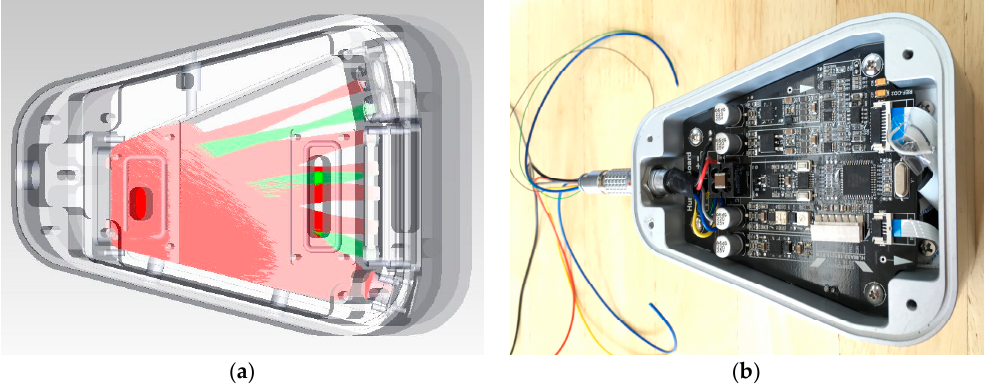
Figure 1. Developed NDIR CO 2 gas sensor for the application of TOC system: ( a ) brief optical path and structure; ( b ) signal conditioning circuitry in sensor